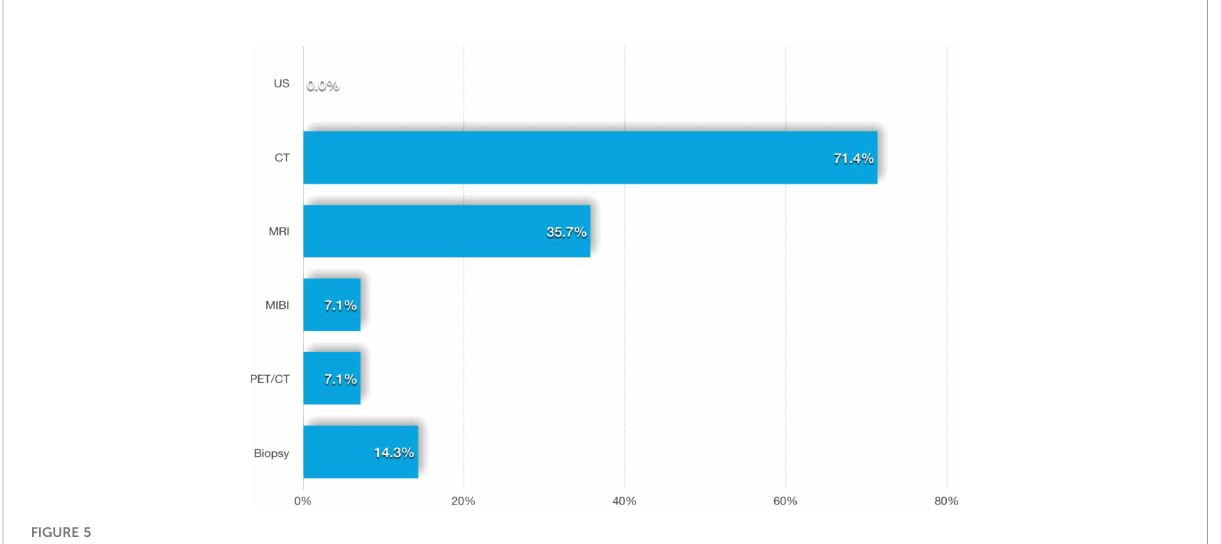
FIGURE 5 Different methods for locate the liver metastases.